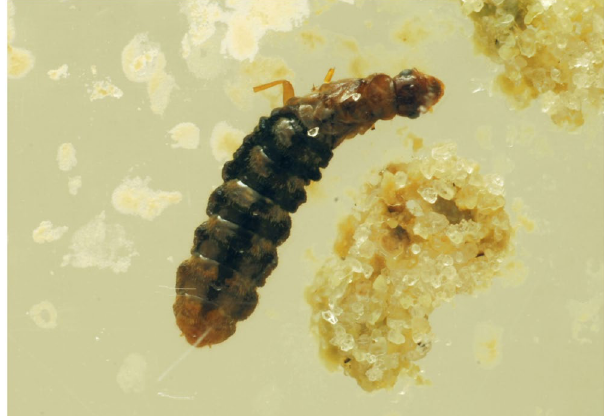
Figure 5. Dead queen with lost legs due to excessive grooming by workers in colony ‘D’ treated with noviflumuron.